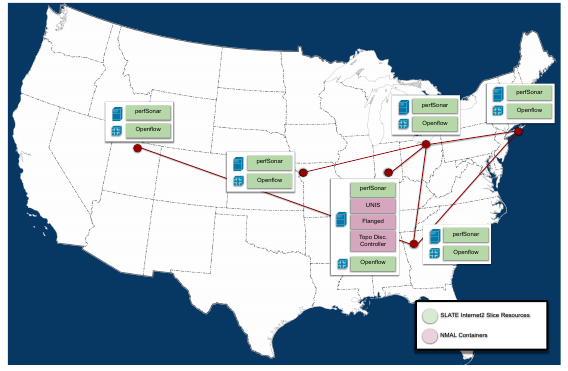
Figure 2. Internet2 SDN Testbed with NMAL and SLATE